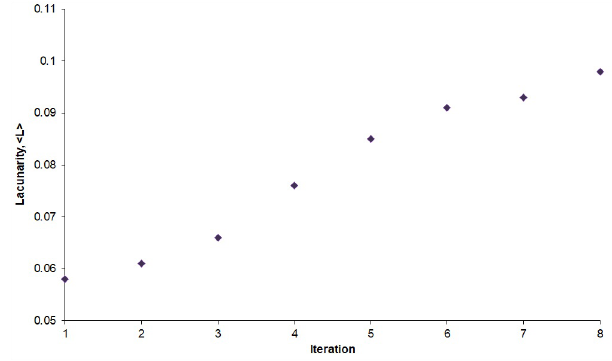
Figure 5. Variation of lacunarity with iterations for deterministic fracture-fractal patterns ( i = 1 to 8).